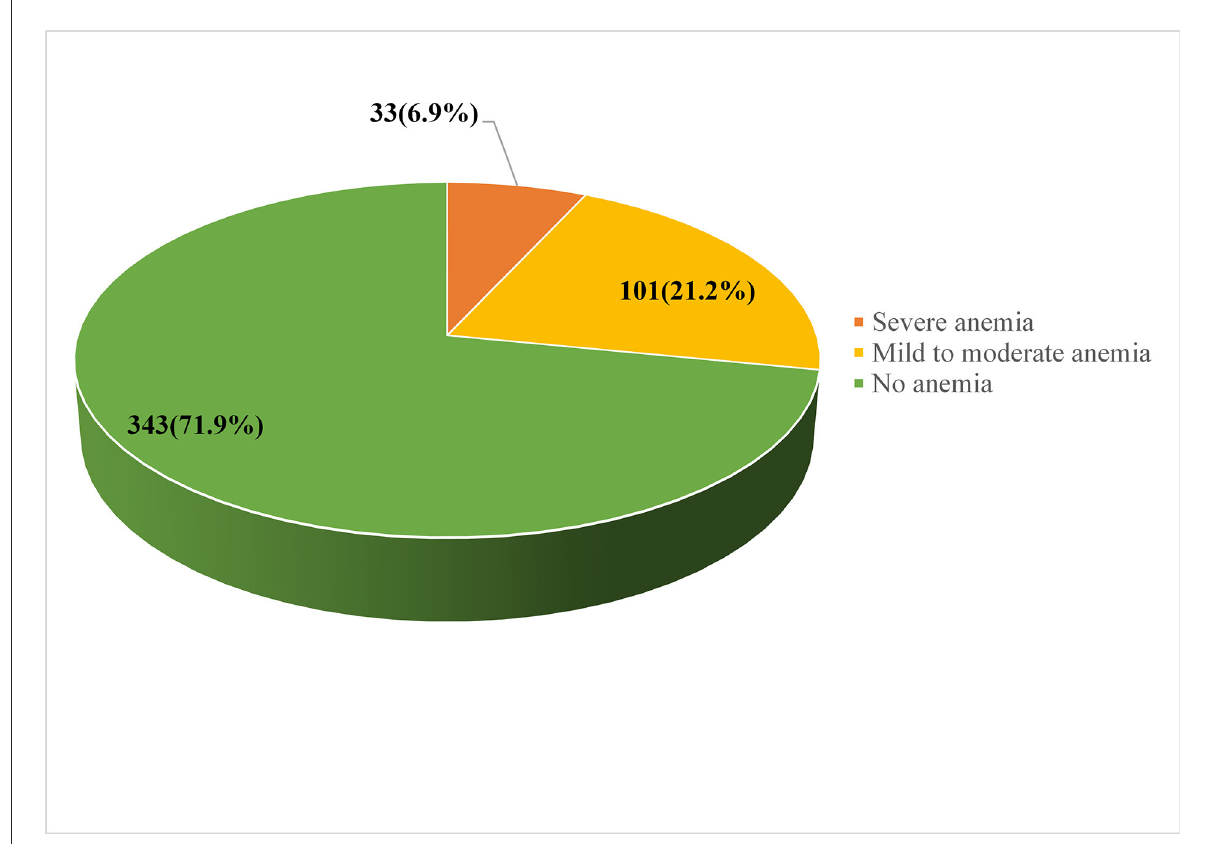
FIGURE3 Magnitude of immediate postpartum anemia among women admitted to the maternity ward in public hospitals in Harari Regional State, Eastern Ethiopia,